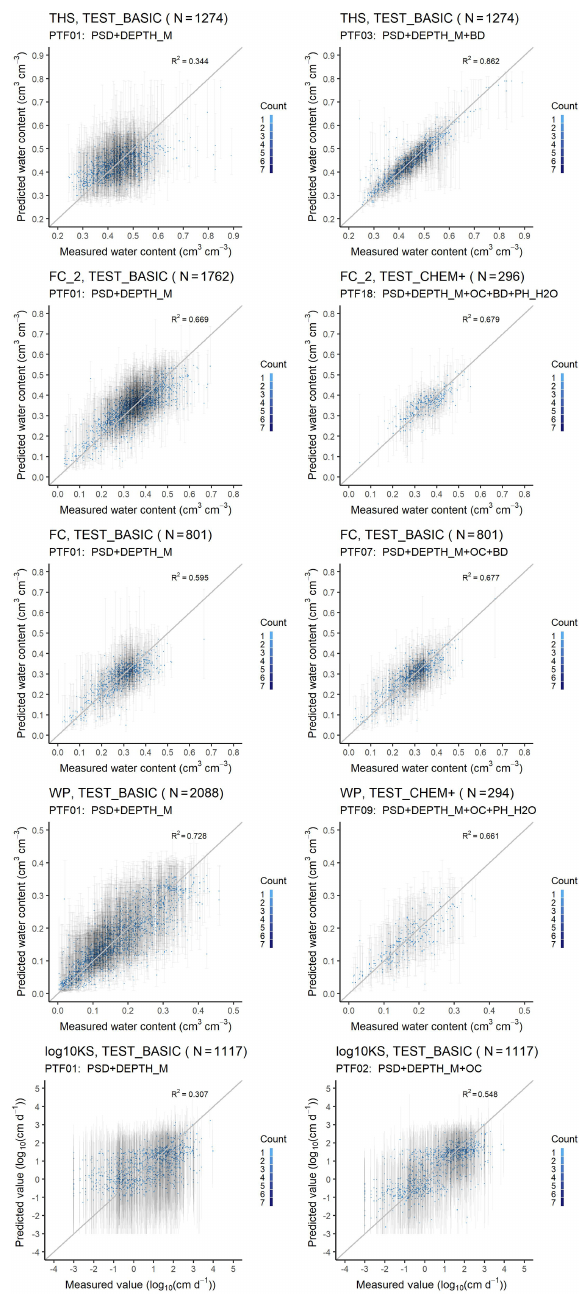
Figure 2. Scatter plot of the measured versus median predicted wa- ter retention values of the worst and best performing PTF with 90% prediction interval on test datasets. THS: saturated water content (PTF01 vs. PTF03); FC_2: water content at − 100cm matric poten- tial head (PTF01 vs. PTF18); FC: water content at − 330cm matric potential head (PTF01 vs. PTF07); WP: water content at wilting point (PTF01 vs. PTF09); log10KS: saturated hydraulic conductiv- ity (PTF01 vs. PTF02); PSD: particle size distribution (sand, 50– 2000µm; silt, 2–50µm; clay, < 2µm (mass%)); DEPTH_M: mean soil depth (cm); OC: organic carbon content (mass%); BD: bulk density (gcm − 3 ); PH_H2O: pH in water (–); Count: the number of cases in each